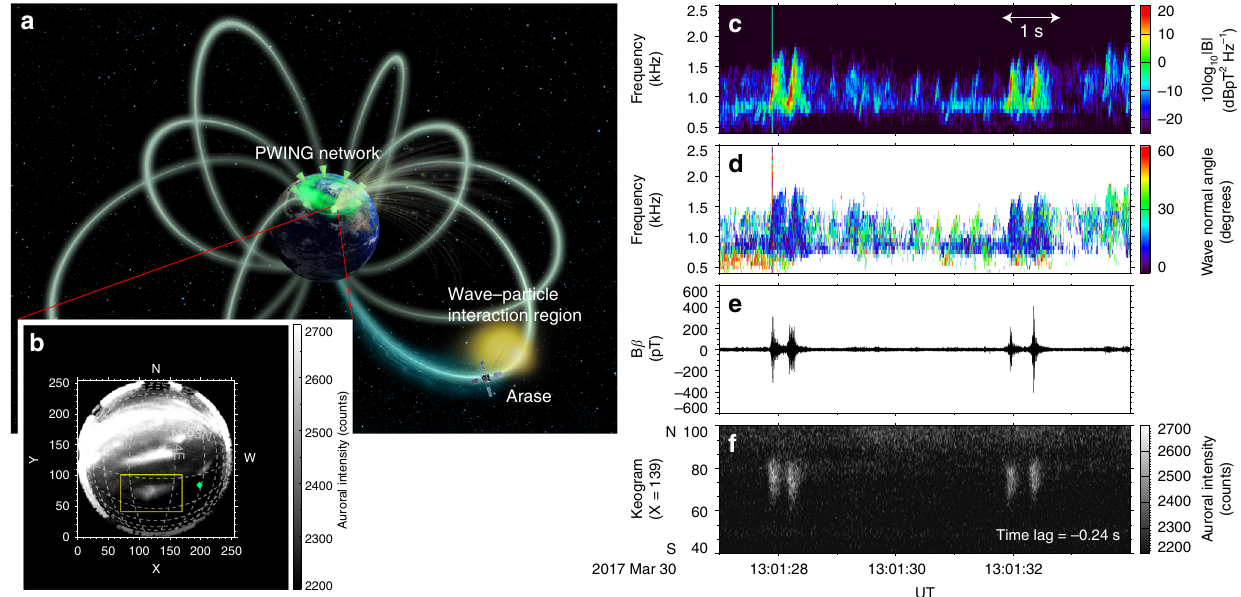
Fig. 1 Coordinated PWING stations and Arase observations. a Illustration of conjugate observations from the PWING ground network and the Arase satellite. Earth in Fig. 1a is mapped using NASA image. All rights reserved. b All-sky EMCCD snapshot observed at Gakona in Alaska at 13:01:28 UT, 30 March 2017. Dotted lines indicate the spacing of geographical latitudes and longitudes at 1° and 2° intervals. The yellow frame indicates the auroral region that is focused on in this study. The green diamond symbol indicates Arase ’ s footprint at the time of observation. c – e The dynamic spectrum, wave-normal angle with respect to the geomagnetic fi eld line, and the waveform of large-amplitude chorus elements observed by Arase near the magnetic equator. f North to South keogram of auroral emissions with a time shift of − 0.24s